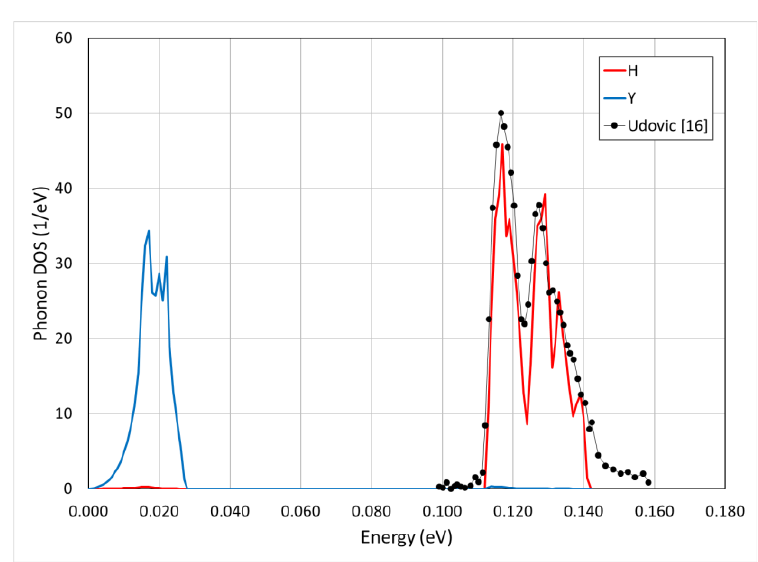
Figure 2. Comparison of Calculated [5] and Measured [16] Phonon DOS for YH